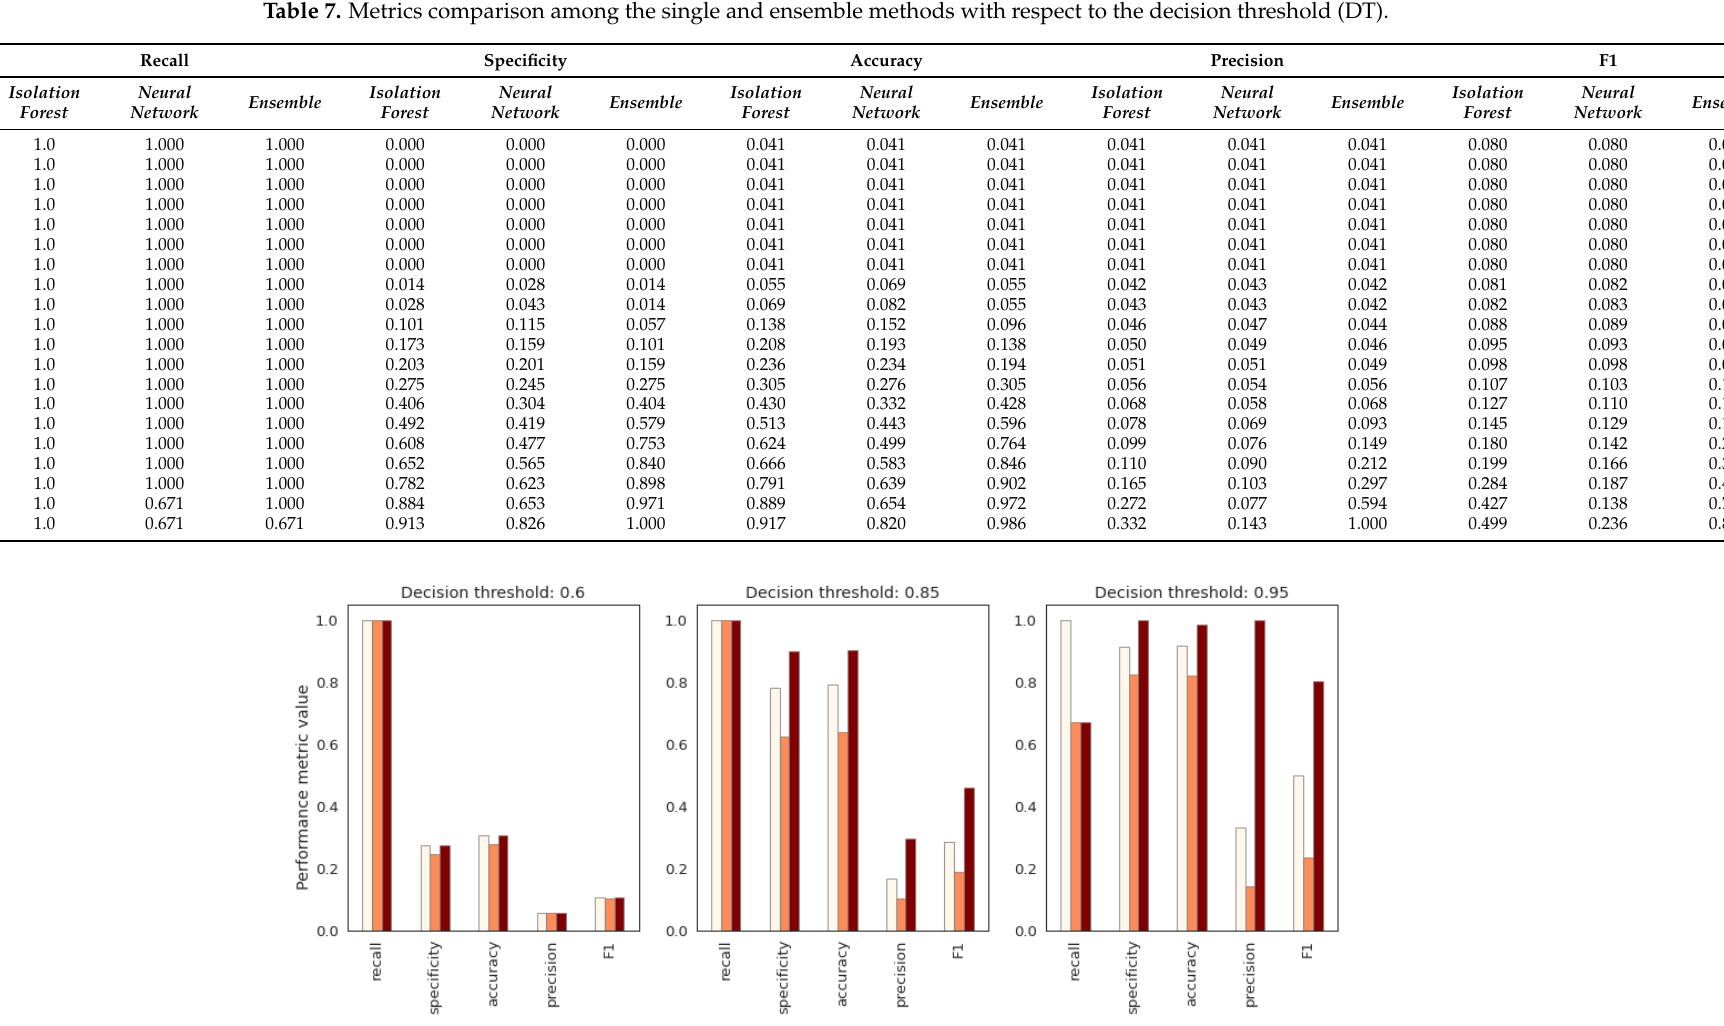
Figure 8. Performance metrics comparison for three different decision threshold values. The white bar represents the anomaly detection indicator, the orange one is for the normality indicator, and the red one for the ensemble